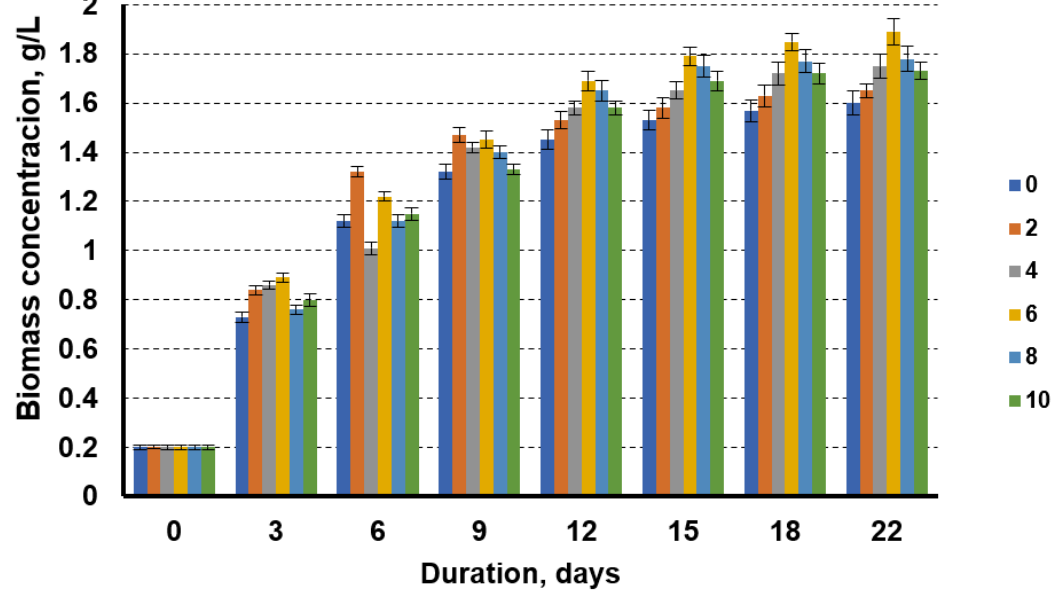
Figure 4. Growth dynamics of microalgae in the nutrient medium with the liquid fraction after biogas production from sewage sludge with a nitrogen concentration of 0.08 g/L and glycerol concentrations of 0 g/L, 2 g/L, 4 g/L, 6 g/L, 8 g/L, and 10 g/L.